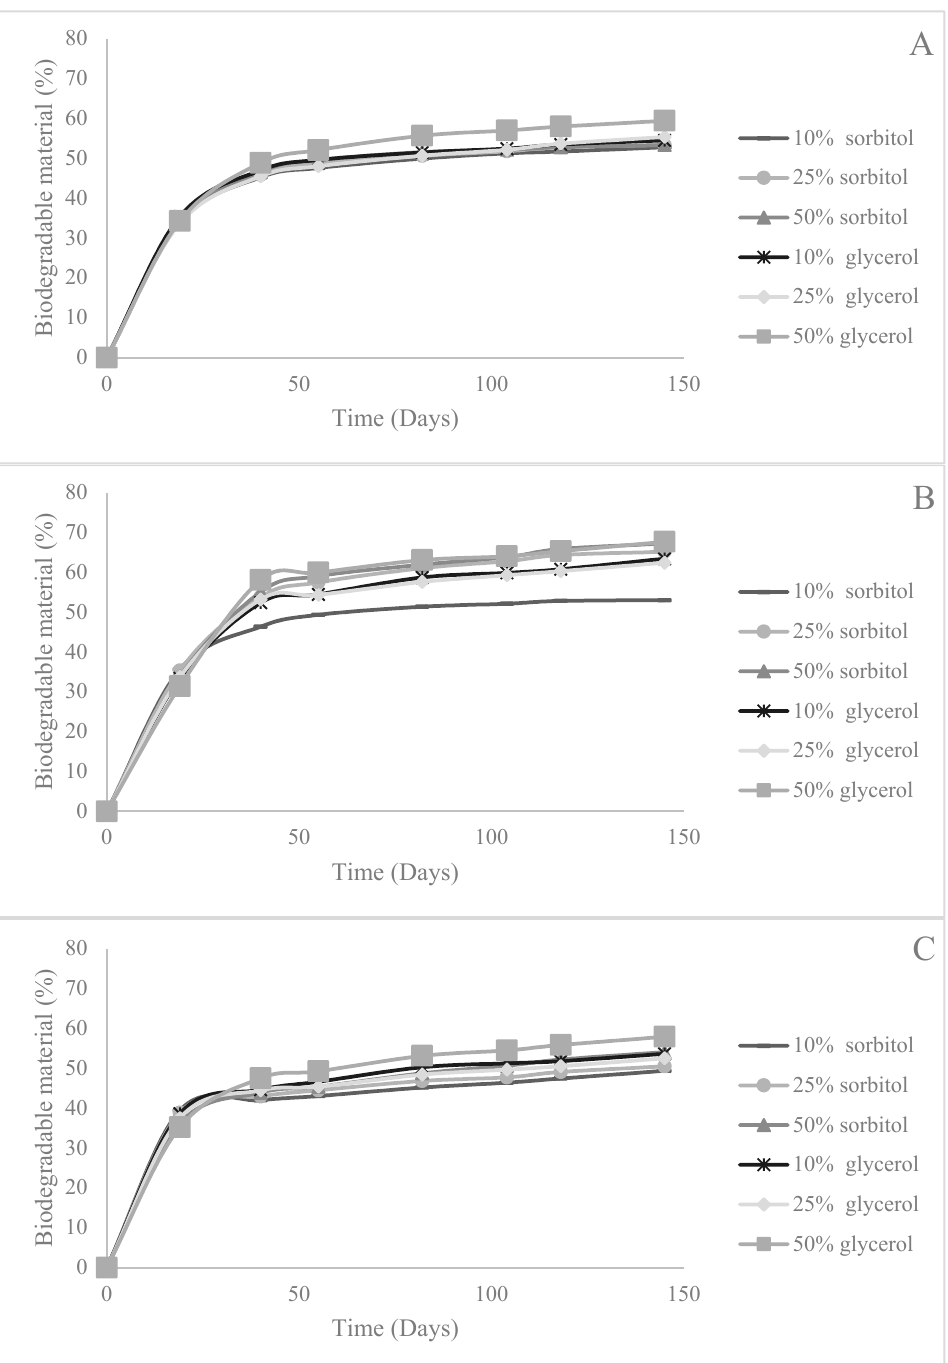
Figure 2. Biodegradability profiles for films made with wheat bran arabinoxylan (A) , maize bran arabinoxylan (B) , and dried distillers grain arabinoxylan (C) .